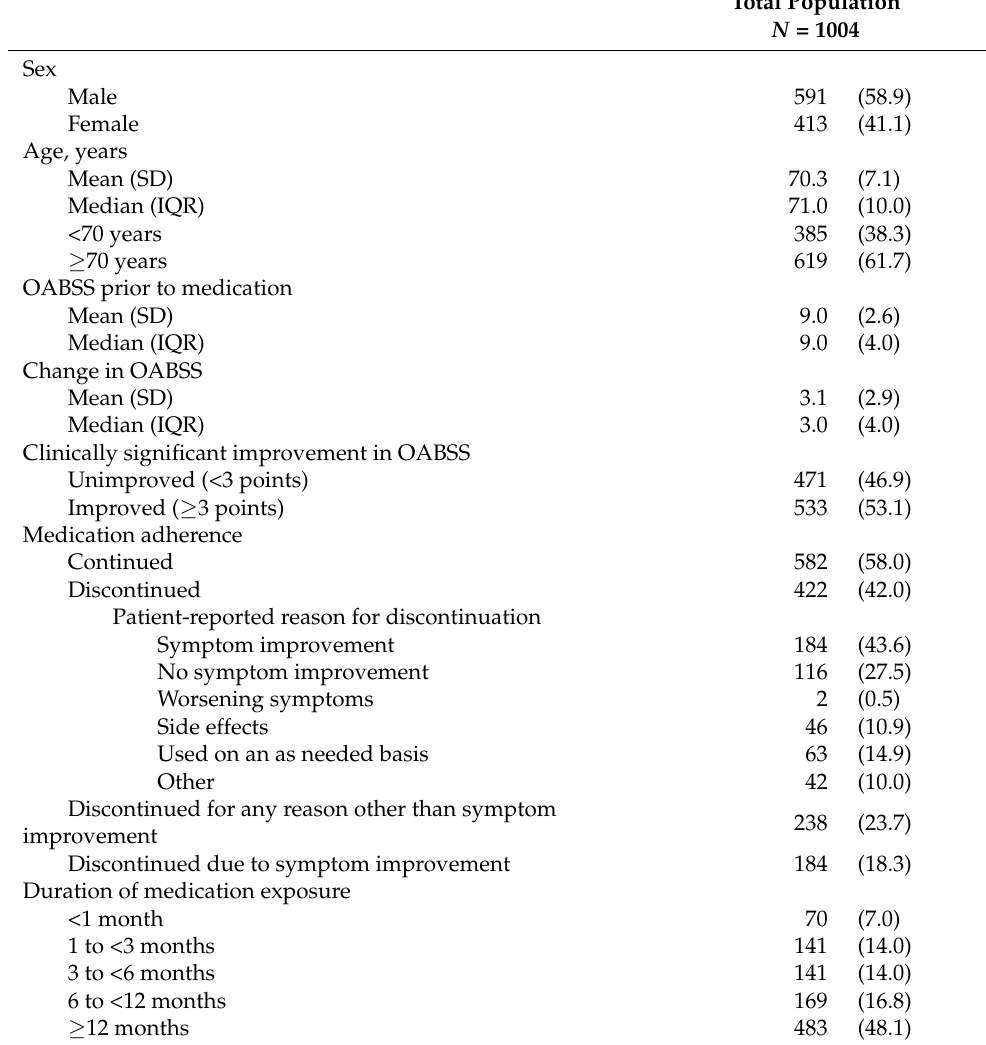
Table 1. Patient